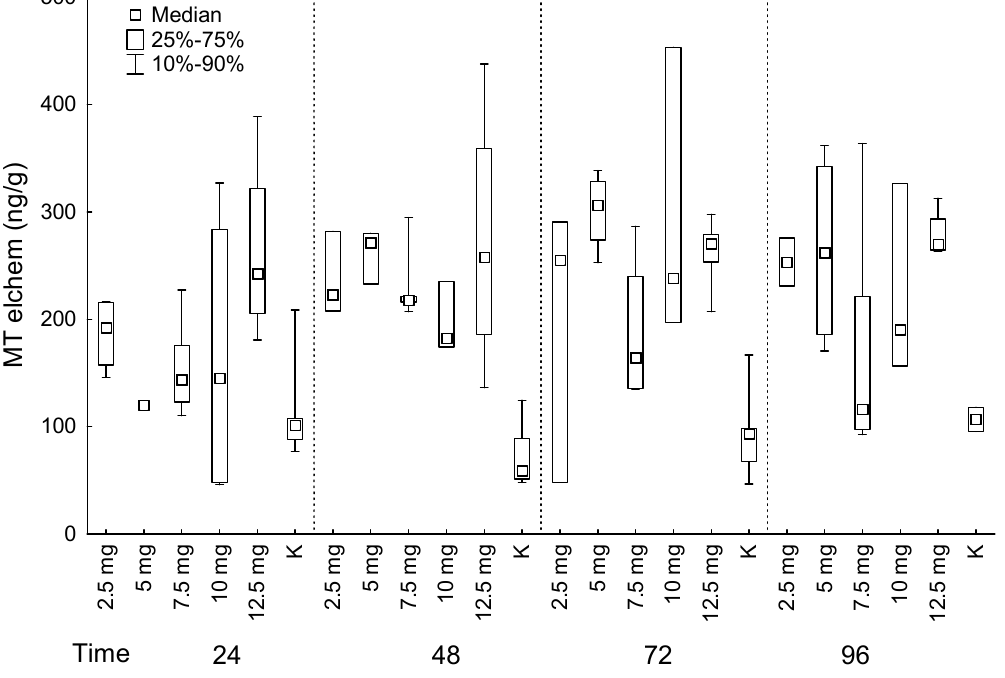
Figure 5. KIDNEY: MTs (ng/g) in fish grouped according the exposition to cadmium chloride (mg/L) (K–control